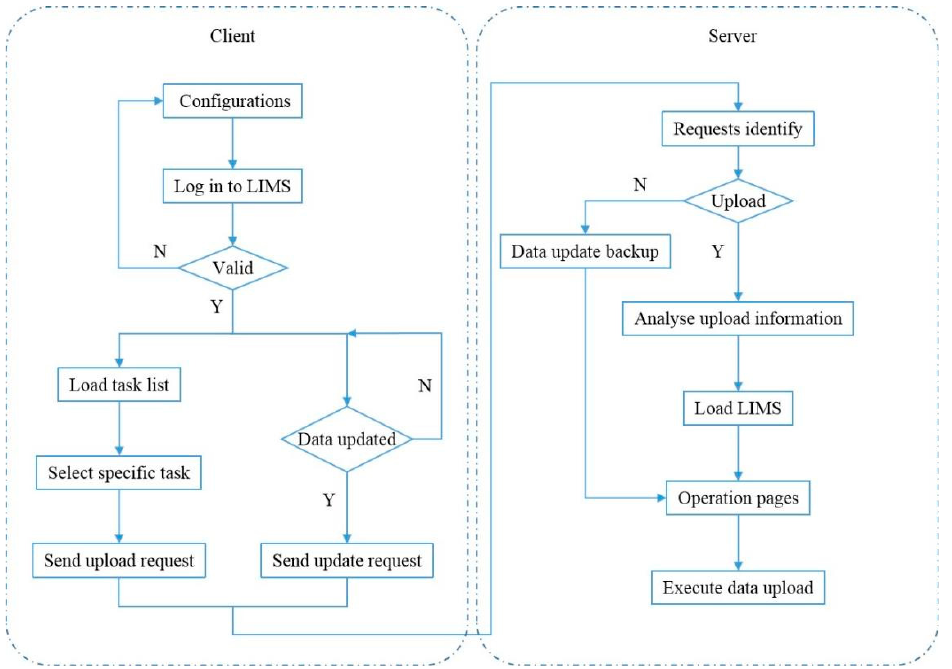
Figure 7. Workflow of an automatic uploading method for customer data in the LIMS system under the user mechanism.